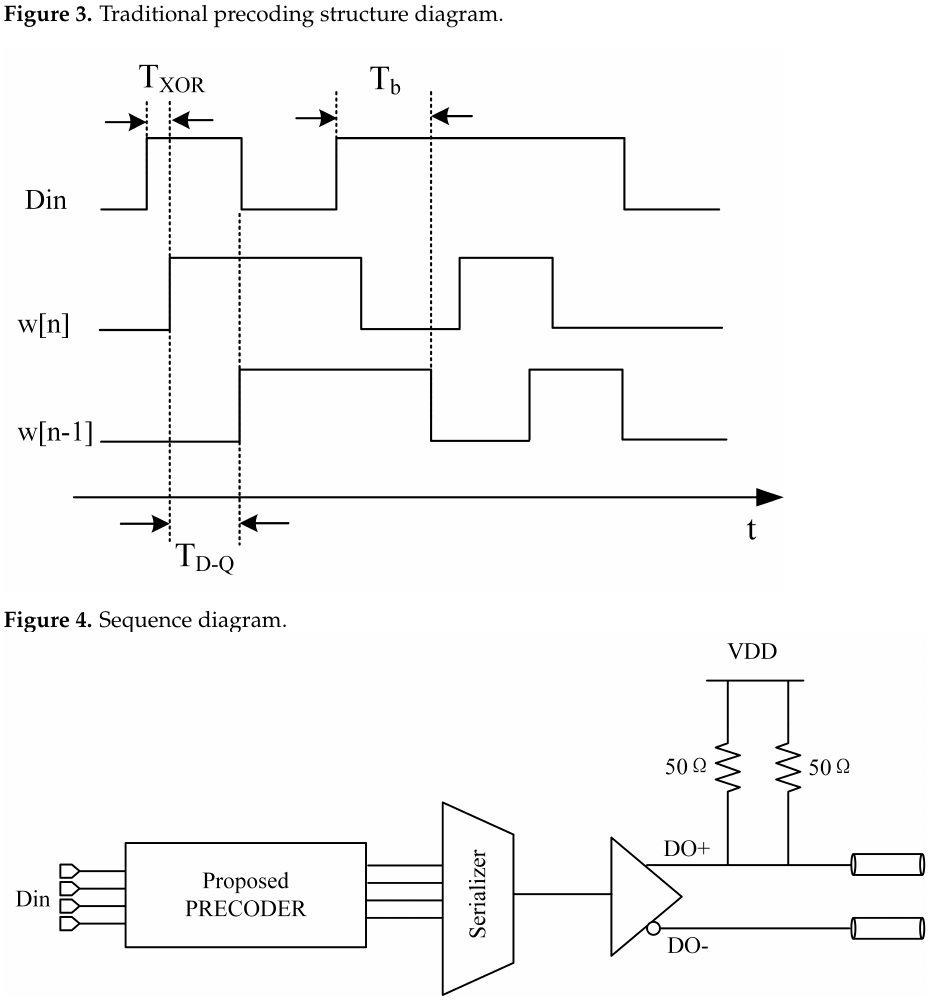
Figure 5. Proposed precoding structure